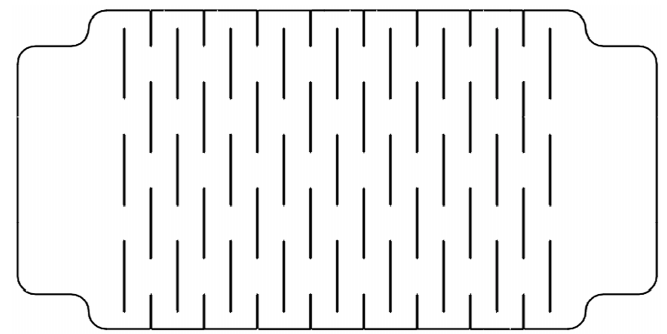
Figure A18. Spiral Fabric Design KL-6. Kirigami long cuts, Thermionyx fabric.